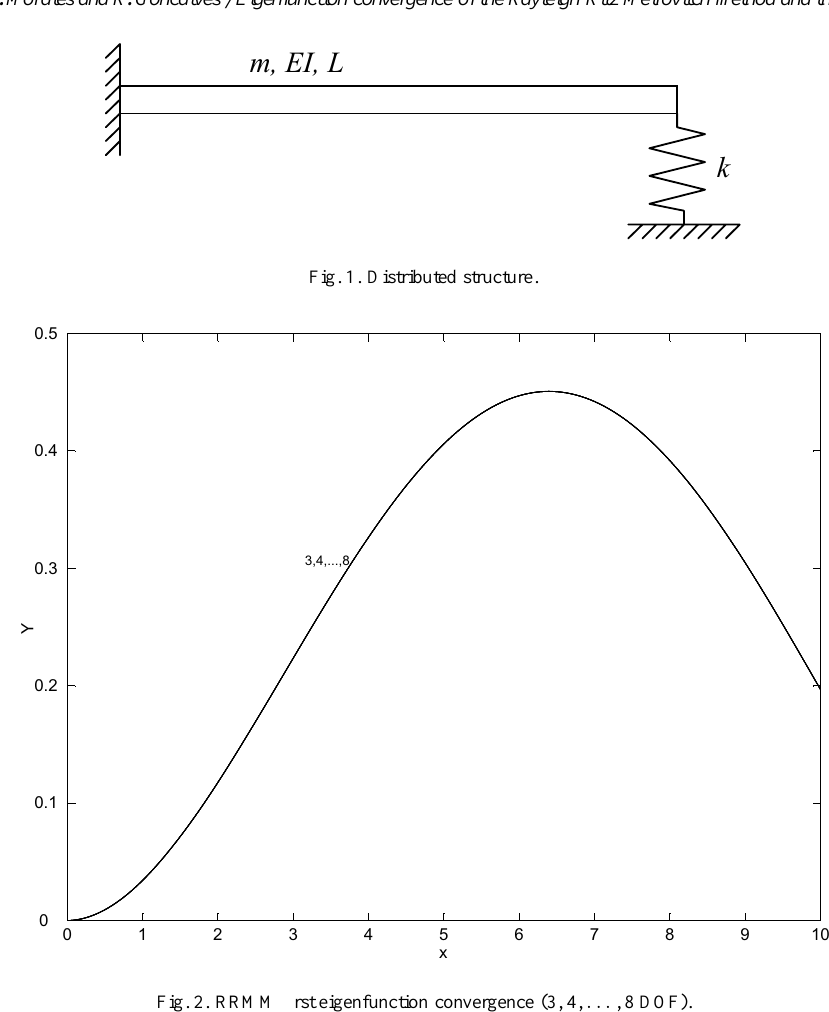
Fig. 2. RRMM first eigenfunction convergence (3, 4, ... , 8